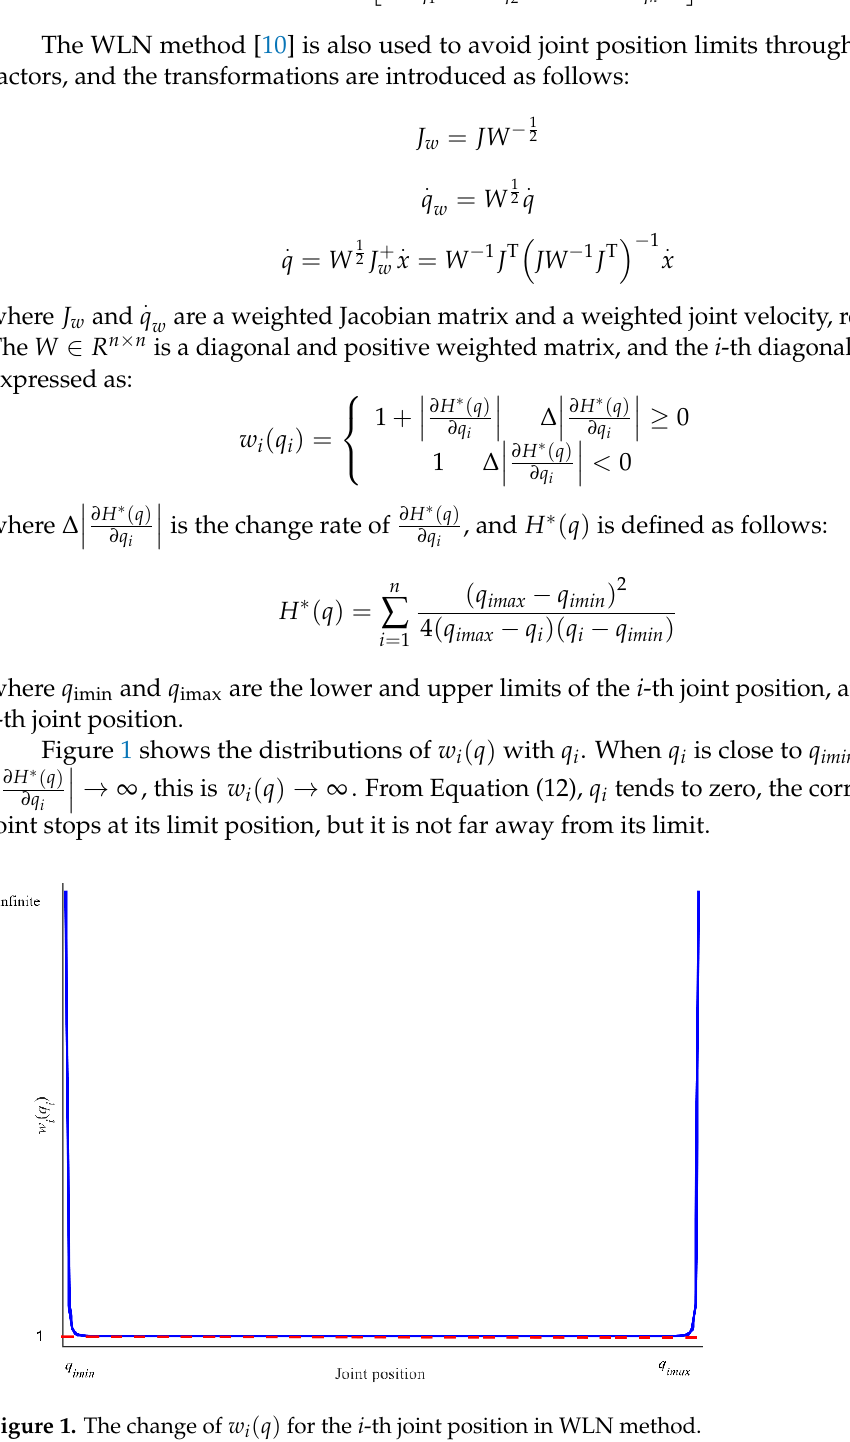
w q for the i- th joint position in WLN Figure 1. The change of ( ) i